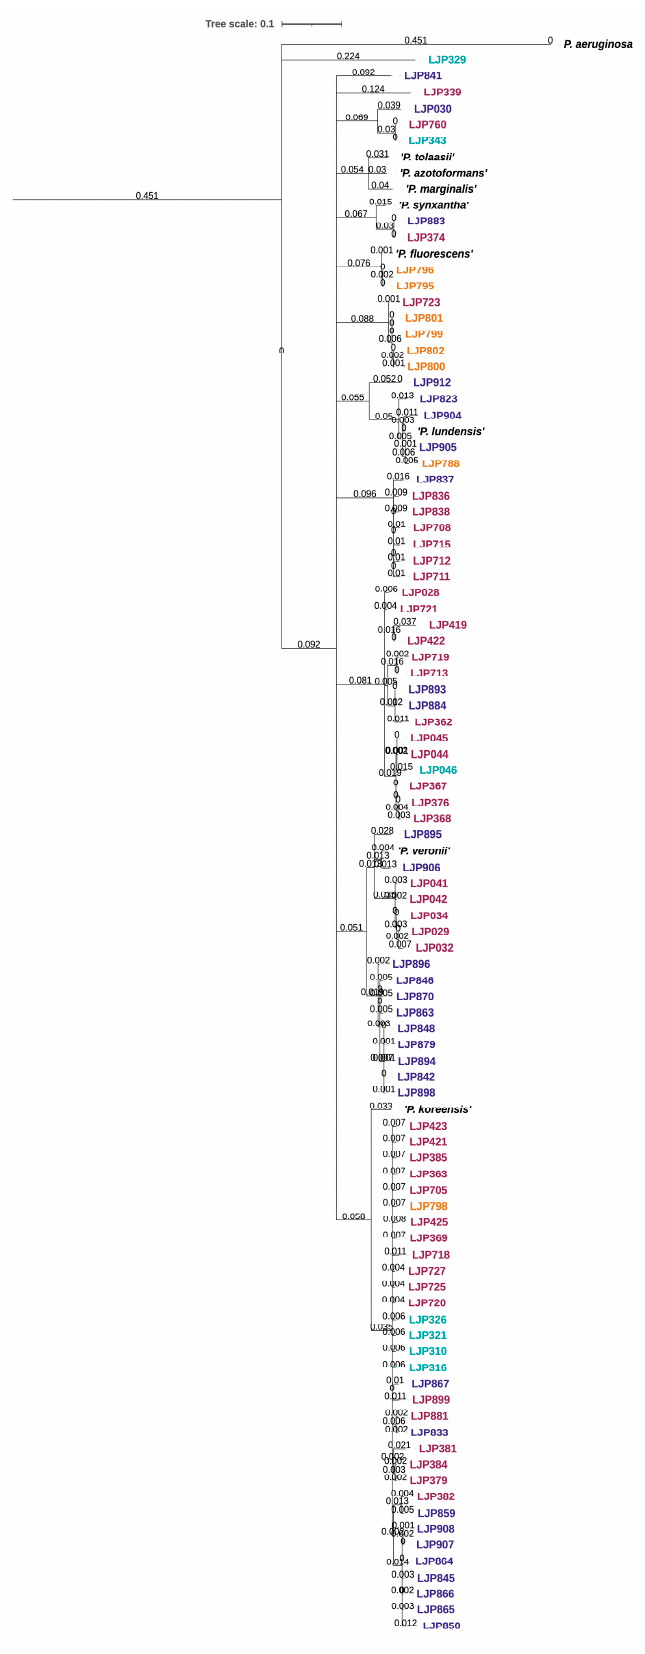
Figure 1. Phylogenetic distribution of Pseudomonas isolates ( n = 89) based on partial sequencing of the rpoD gene. The trimmed sequences were aligned and cut to equal length (~700 bp) and